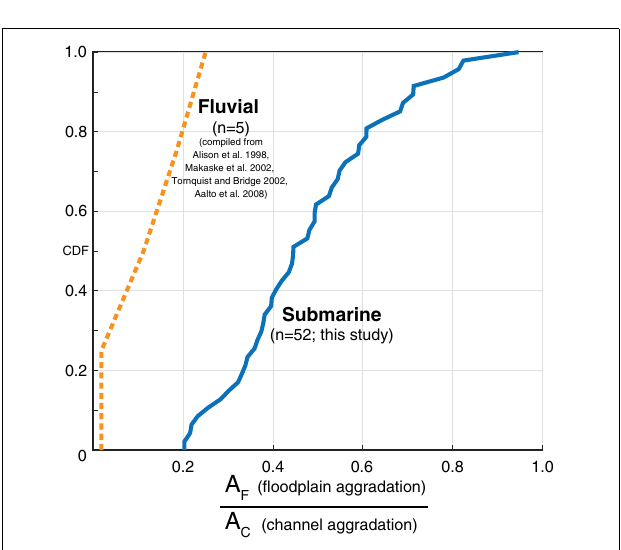
FIGURE 6 | Ratio between channel aggradation and floodplain aggradation in fluvial and submarine channel-belts. This relationship suggests that the relative contribution of floodplain aggradation is much more important in submarine channel belt growth, supporting the formulation of Eqs. 3 and 4.